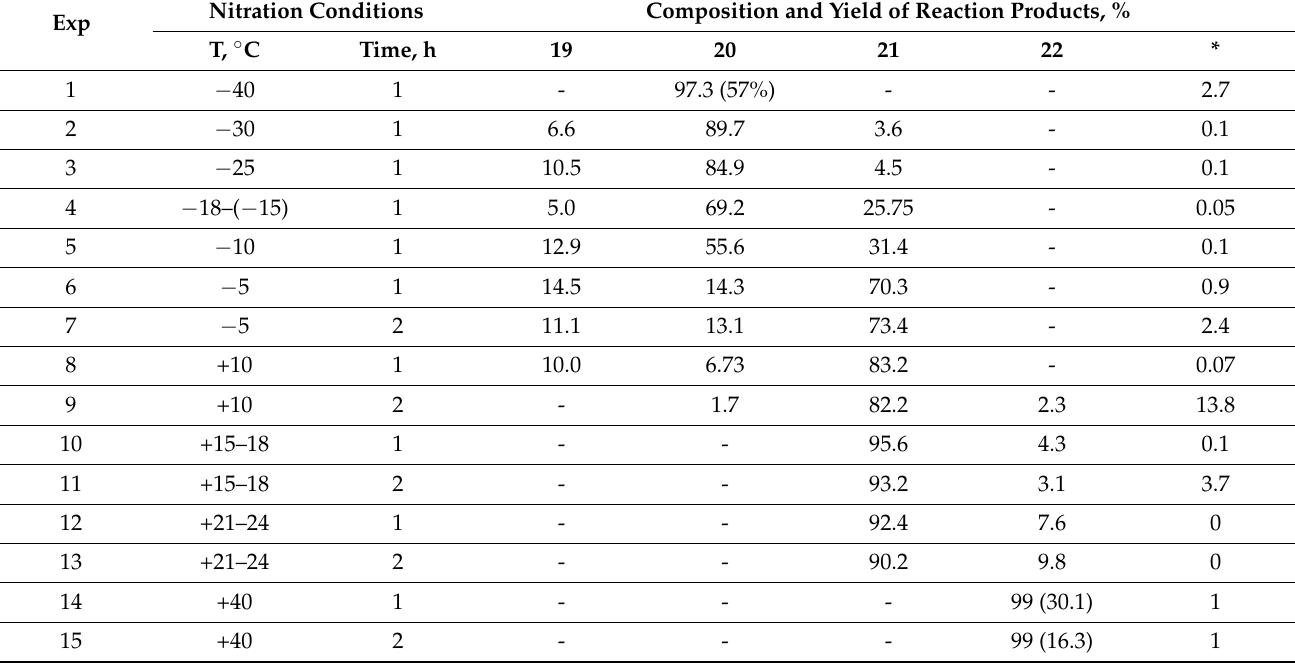
Table 2. Nitration of 19 with concentrated HNO 3